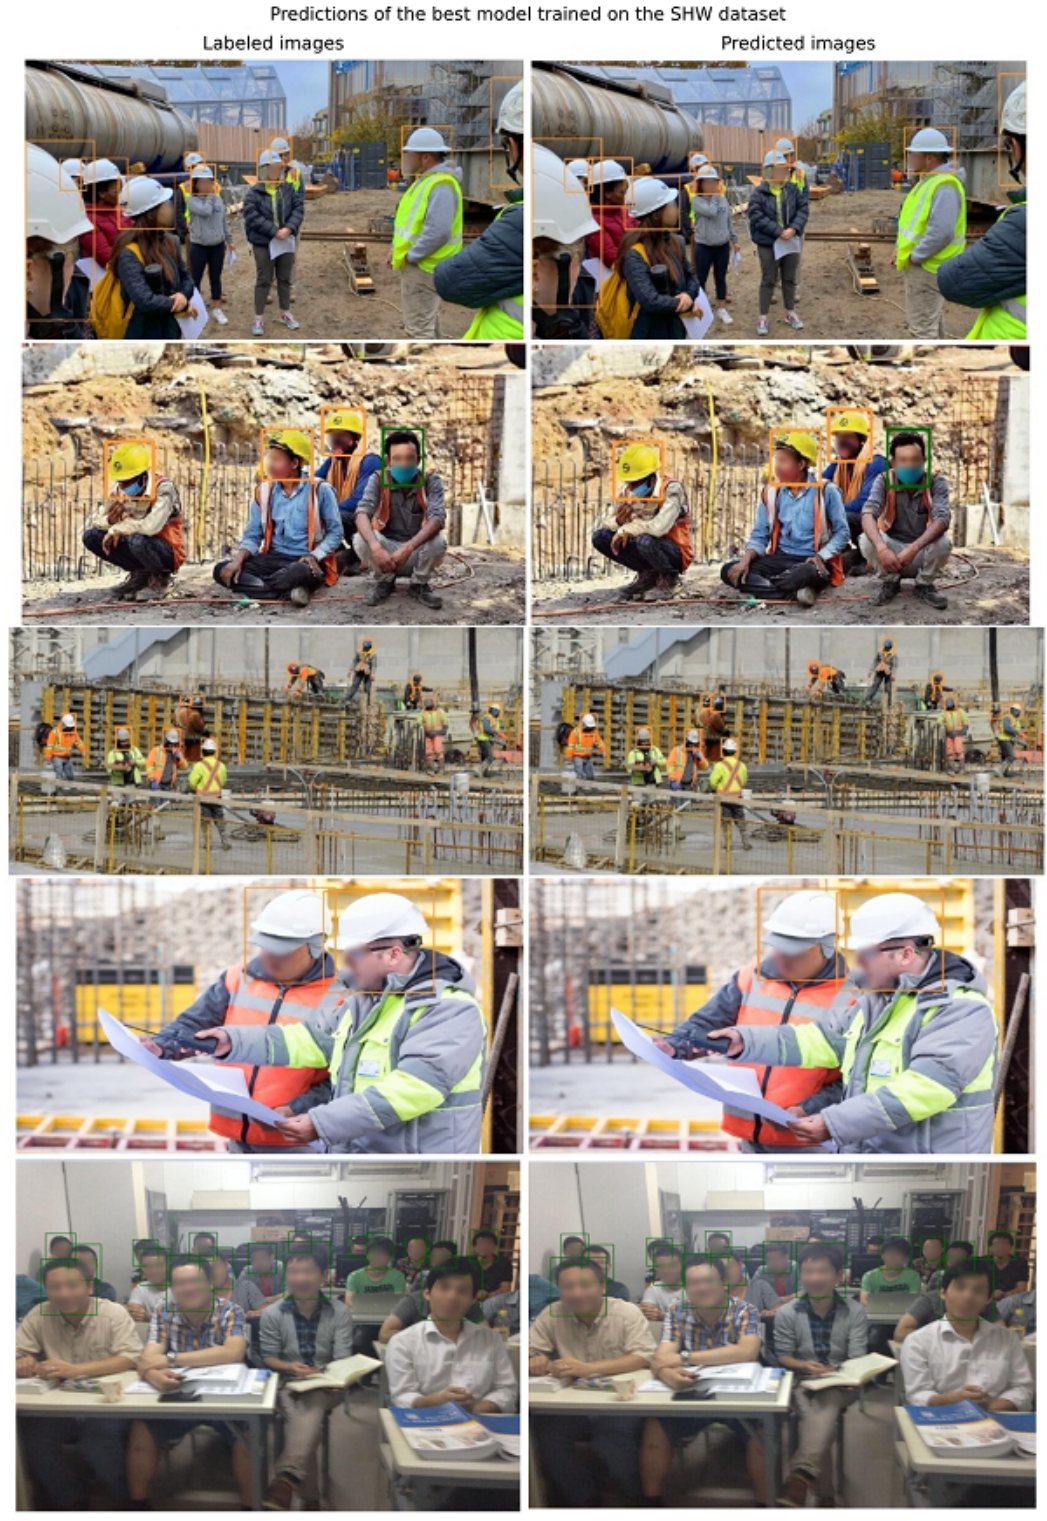
Figure A3. Predictions of the best model trained on the SHW dataset [28] and the ground truth labels of the sample